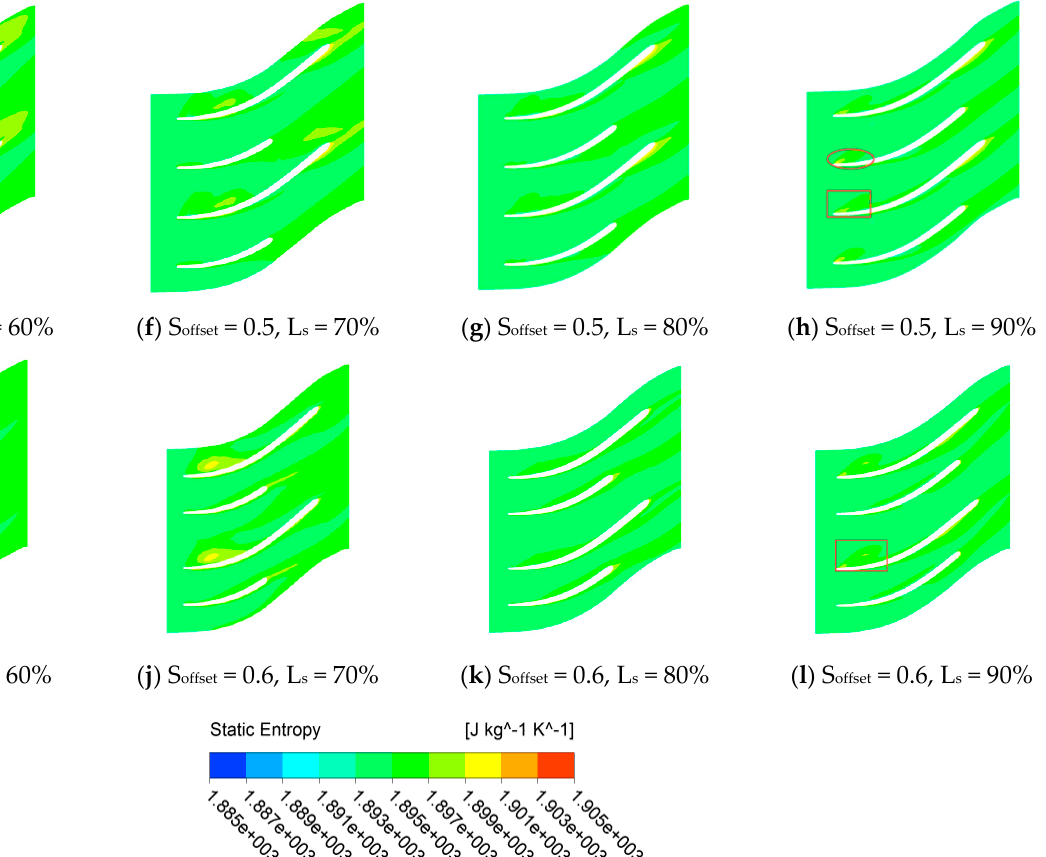
Figure 10. Contour of static entropy distribution when span = 0.5.